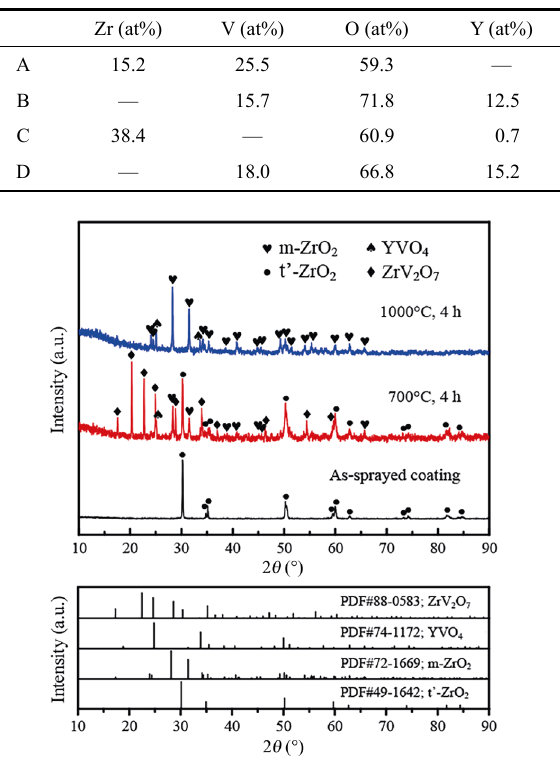
Fig. 5 Surface morphologies of the as-sprayed YSZ coatings after hot corrosion tests at (a, b) 700 ℃ and (c, d) 1000 ℃ . Table 3 Chemical compositions of the different regions A–D in Fig. 5